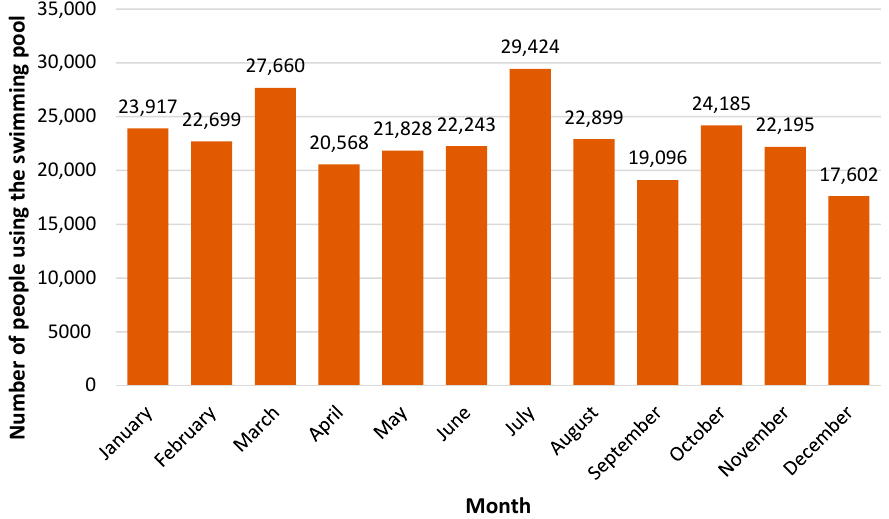
Figure 2. Summary of the number of people using the swimming pool based on 2018.